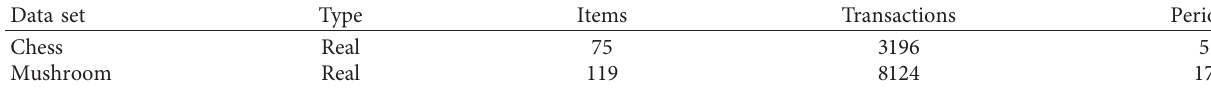
Table 5: Basic description of the data